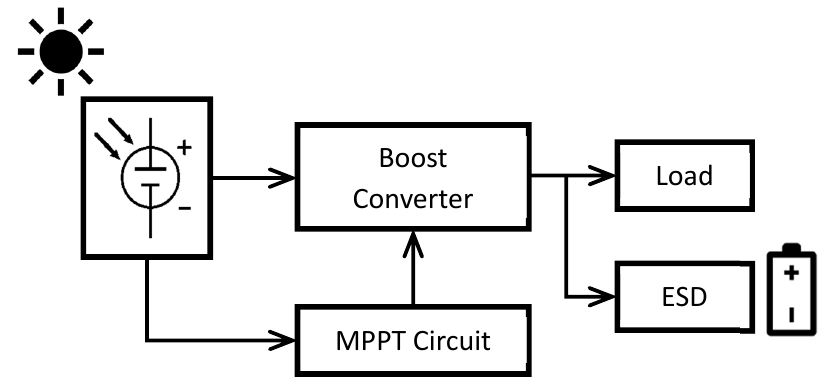
Figure 4. Schematic of a typical solar energy harvesting circuit.